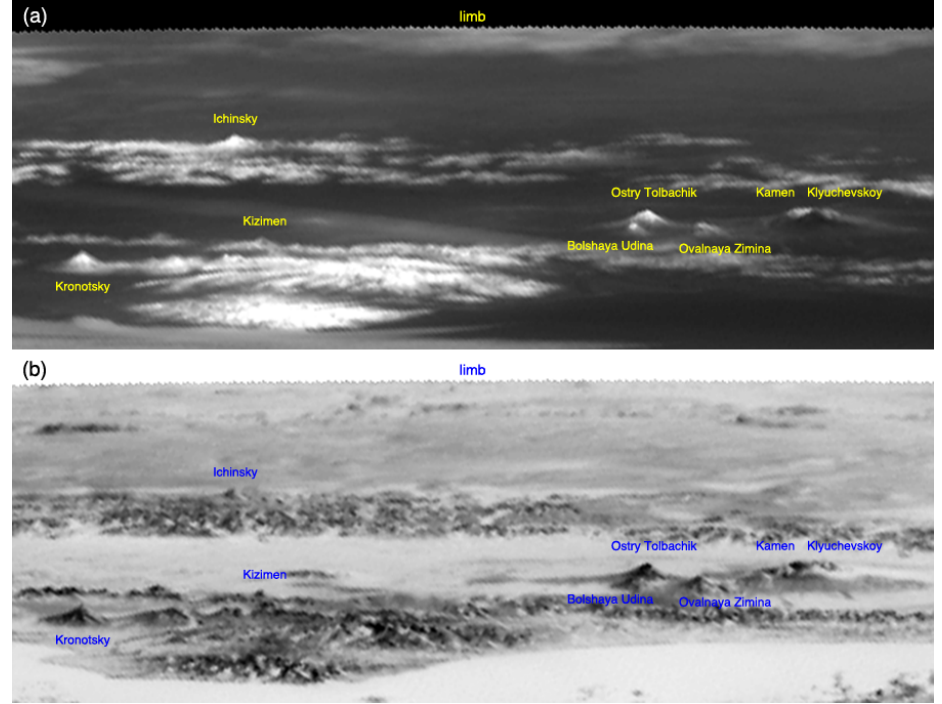
Figure 6. GOES-17 band 2 fixed grid image of central Kamchatka on (a) 13 June 2020 at 23:00UTC and (b) 21 December 2019 at 23:50UTC with the most prominent volcanic peaks labeled. The images were magnified by a factor of 3, rotated clockwise by 31 ◦ to ensure a horizontal limb, and an inverted black–white gradient map was applied to panel (b) to mimic a shaded relief